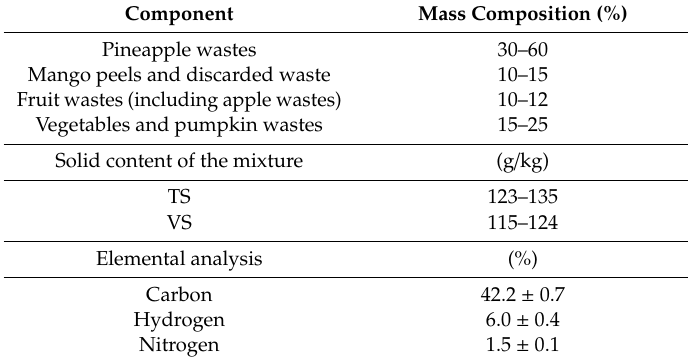
Table 1. Characteristics of the substrate used in the testing of the small-scale anaerobic reactor.